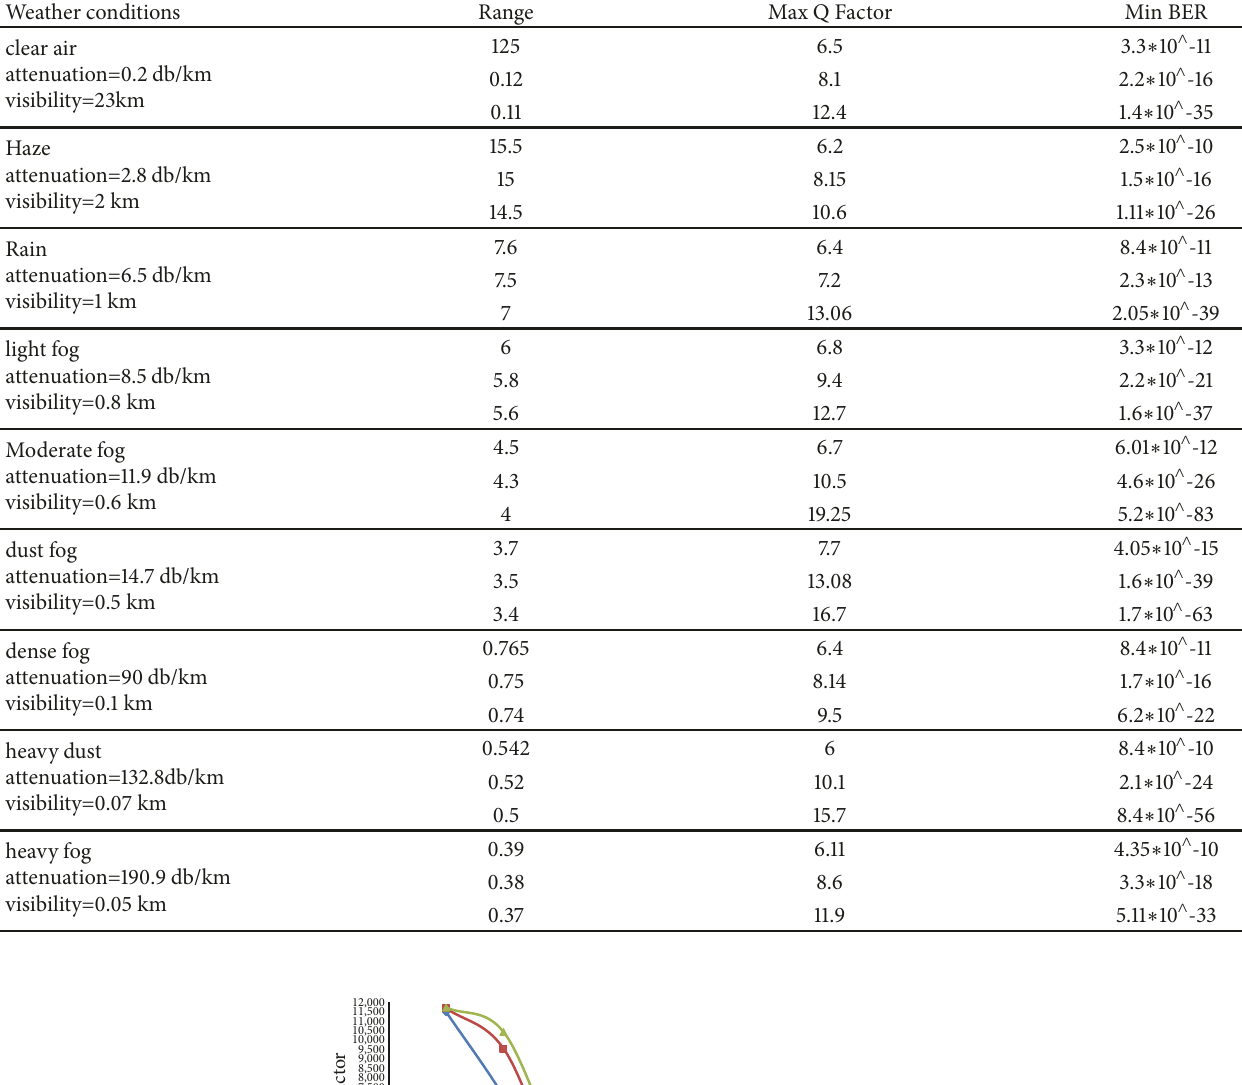
Table 5: Results for 4T 𝑋 /4R 𝑋 FSO at different weather conditions for 𝜆 = 1550 nm.